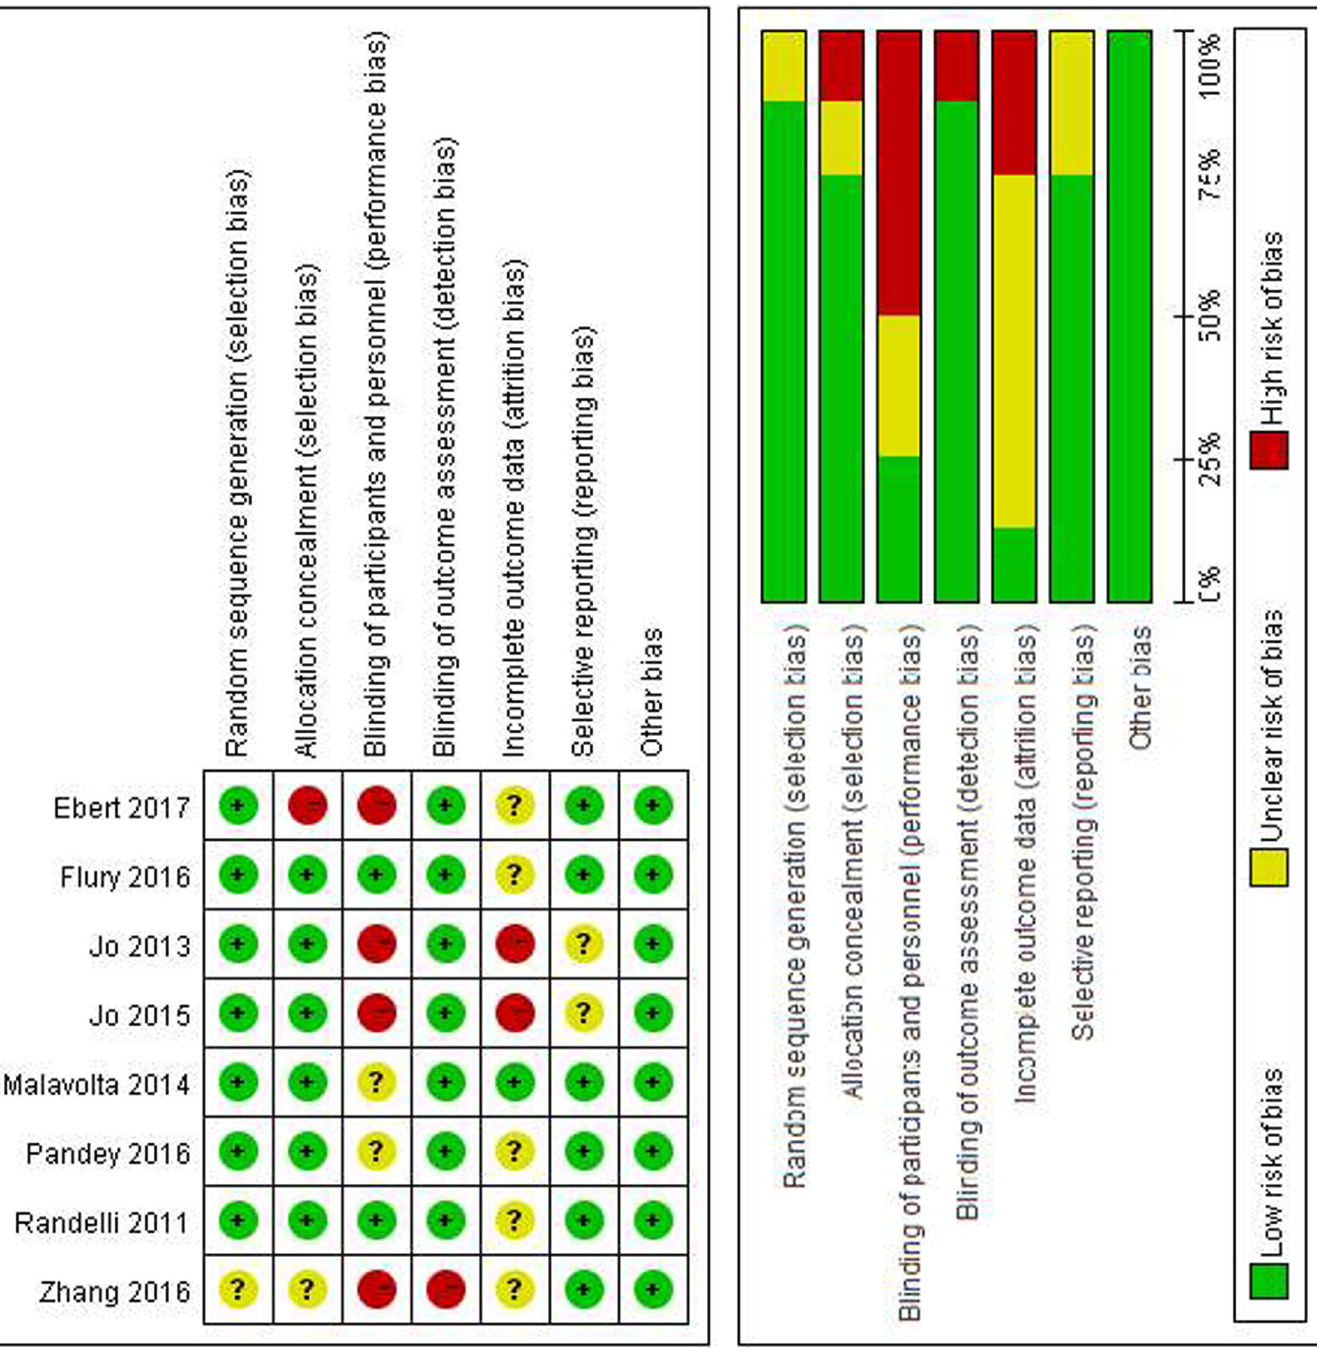
Fig 2. The methodological quality of the included studies. (SMD = 0.48, 95% CI [0.20, 0.76], P = .0009) and double-row fixation (SMD = 0.29, 95% CI [0.06, 0.53], P = .01) (Fig 5). The quality of the above evidence was rated as moderate. Long-term Constant score. Five studies[16–18, 31, 32] reported on the long-term Con- stant scores, including 177 patients in the PRP group and 180 patients in the control group. As